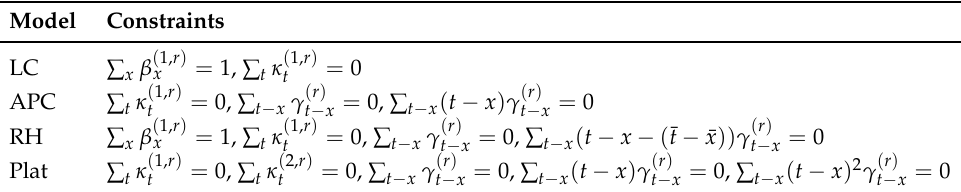
Table 2. Parameter constraints for the reference population model.